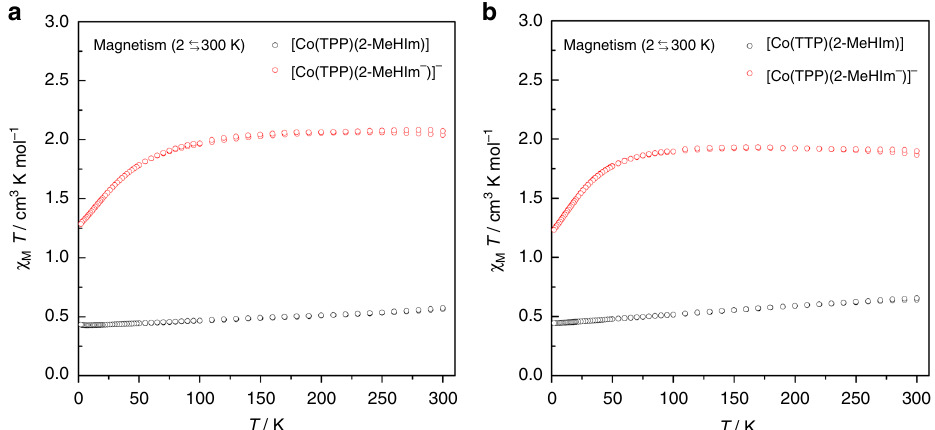
T vs. T in an external magnetic fi eld of 1000 Gauss. a [Co(TPP)(2-MeHIm)] (black circles), [Co(TPP)(2-MeIm − )] − (red circles). b [Co(TTP)(2- Fig. 3 χ M MeHIm)] (black circles), [Co(TTP)(2-MeIm − )] − (red circles)